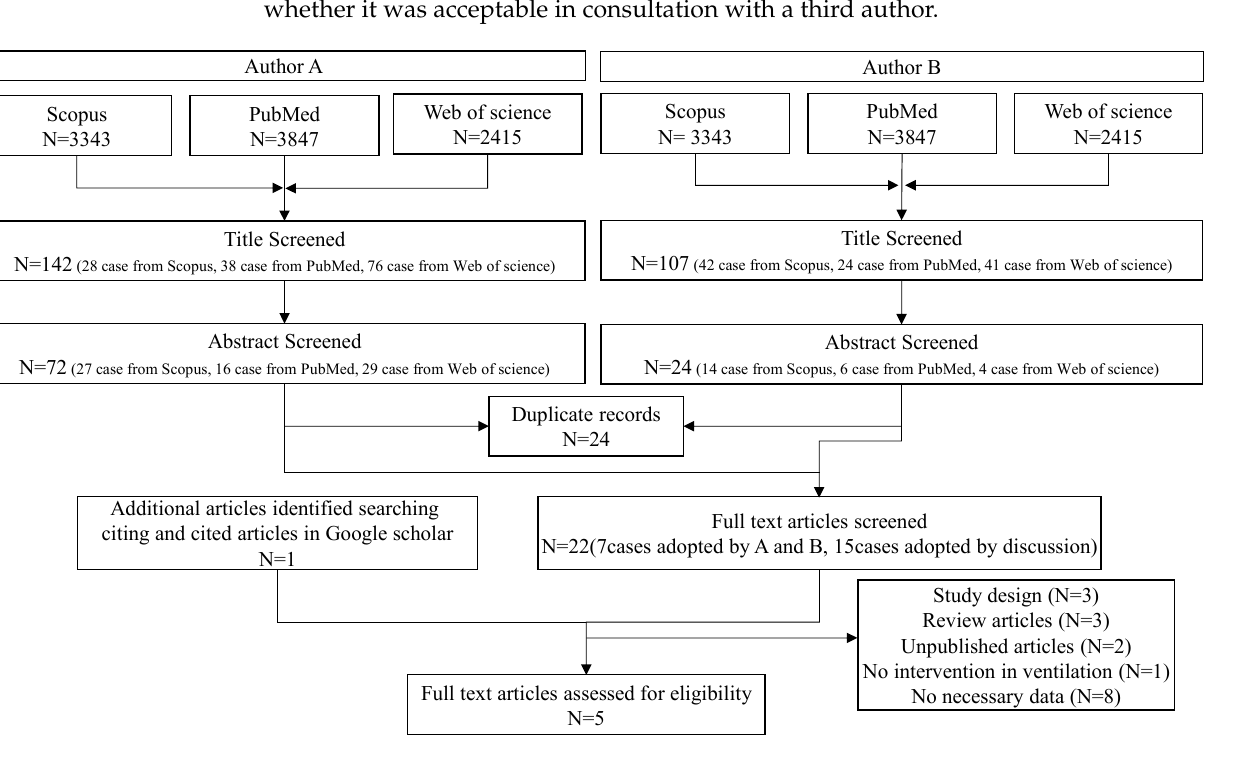
Figure 1. Screening fl ow diagram of the search strategy.